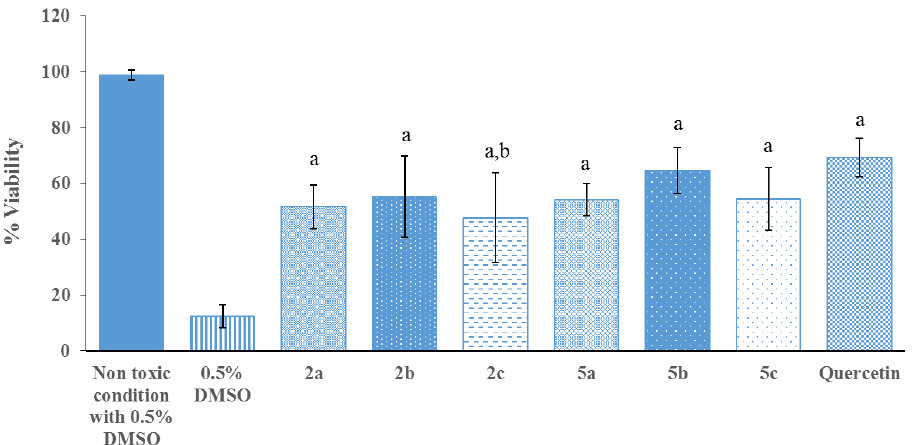
Figure 4. Neuroprotective activities of ascorbic derivatives at a concentration of 1 nM on cultured P19-derived neurons evaluated by serum-deprivation-induced oxidative stress. α-MEM, supplemented with 10 µ M Ara-C, and 1% antibiotics–antimycotic solution without FBS were used to induce the oxidative stress condition. Each bar is presented as mean ± SD ( n = 3). Letter a denotes a significant difference compared with the toxic condition ( p < 0.05), and letter b denotes a significant difference compared with quercetin (1 nM) positive control ( p < 0.05), based on one-way ANOVA using the Origin Pro 9.0 program, Northampton, MA, USA .